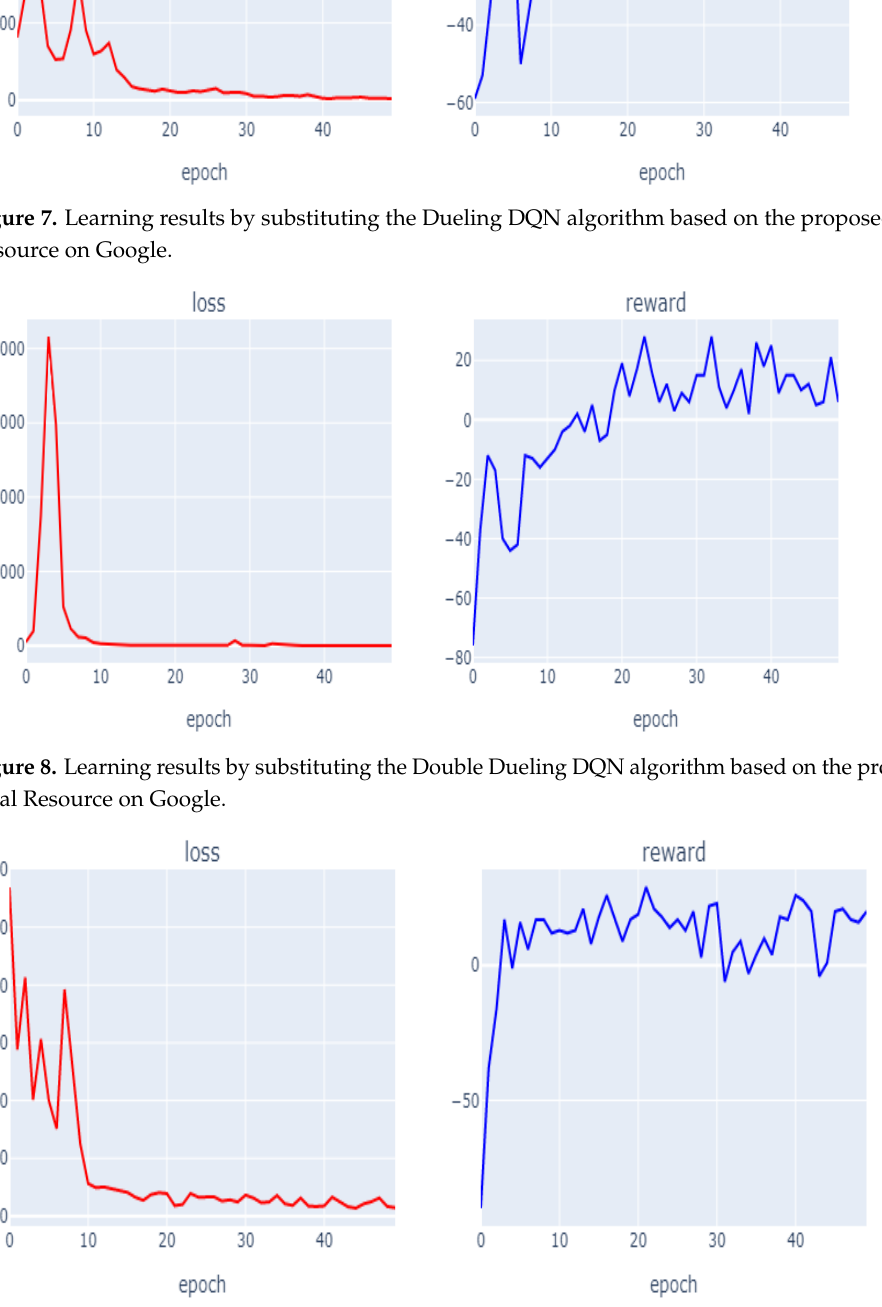
Figure 9. Learning results by substituting the Quad Q Network algorithm based on the proposed Total Resource on